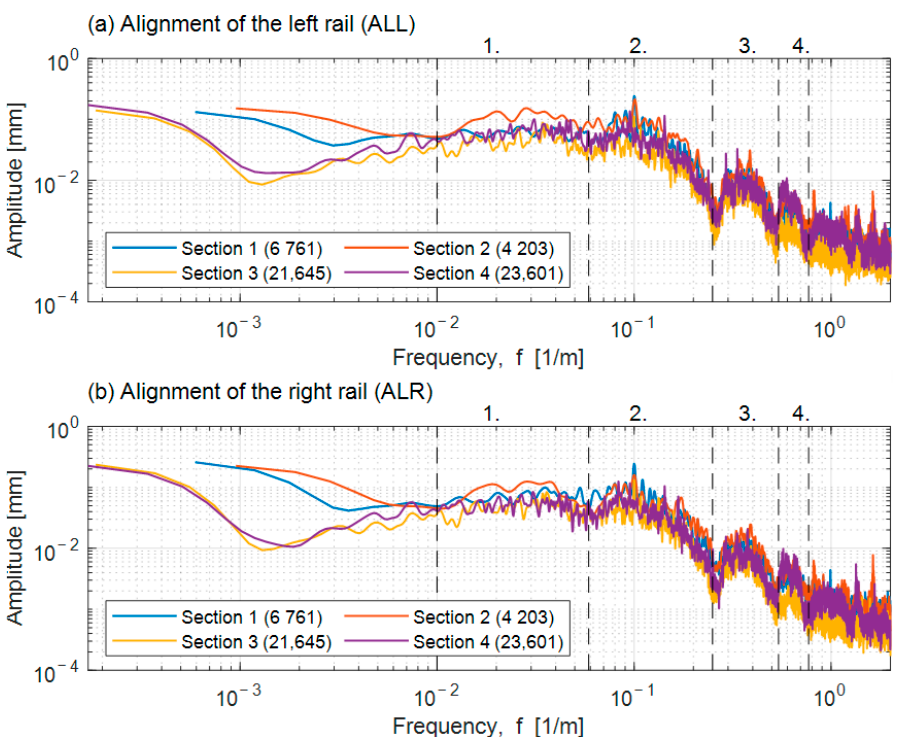
Figure 8. Fourier Amplitude Spectrum (FAS) of ( a ) ALL and ( b ) ALR on the investigated track sections (see Table 1) with the indication of the detected characteristic Wavelength ranges (modes) and the number of samples included in the investigated signal.